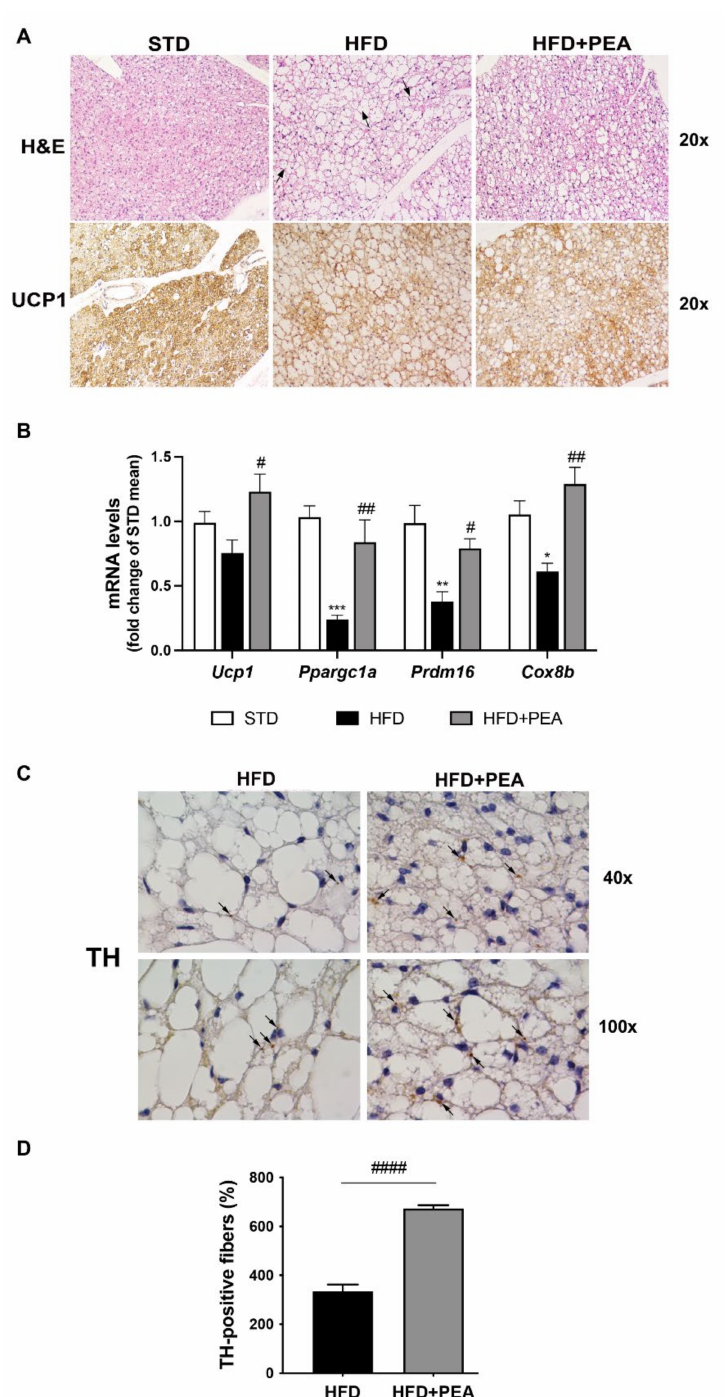
Figure 1. PEA recovers BAT morphology and function altered in obese mice. ( A ) Representative H & E (upper panel) and immunohistochemical staining for UCP1 (lower panel) of iBAT are reported (original magnification 20 × ) (n = 7 animals for each group). Paucilocular adipocytes are indicated by black arrows. ( B ) mRNA transcription levels of Ucp1, Ppargc1a, Prdm16, and Cox8b in iBAT of all experimental groups are evaluated (n = 5–6 each group). ( C ) Representative immunohistochemistry for TH in iBAT of HFD and HFD + PEA mice and ( D ) total count of positive fibers are performed in a double-blinded manner (n = 7 animals for each group) (original magnification 100 × ). Black arrows show positive nerves. Results are shown as mean ± SEM. * p < 0.05, ** p < 0.01, *** p < 0.001, significantly different from STD; # p < 0.05, ## p < 0.01, #### p < 0.0001 from